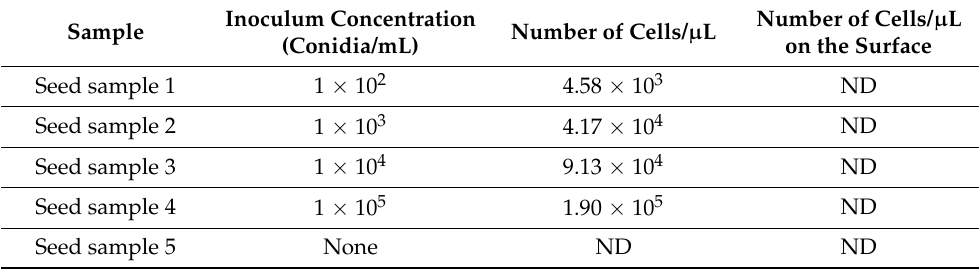
Table 4. Number of cells/ µ L of F. fujikuroi detected in seed samples artificially inoculated with ten-fold serial dilution of the